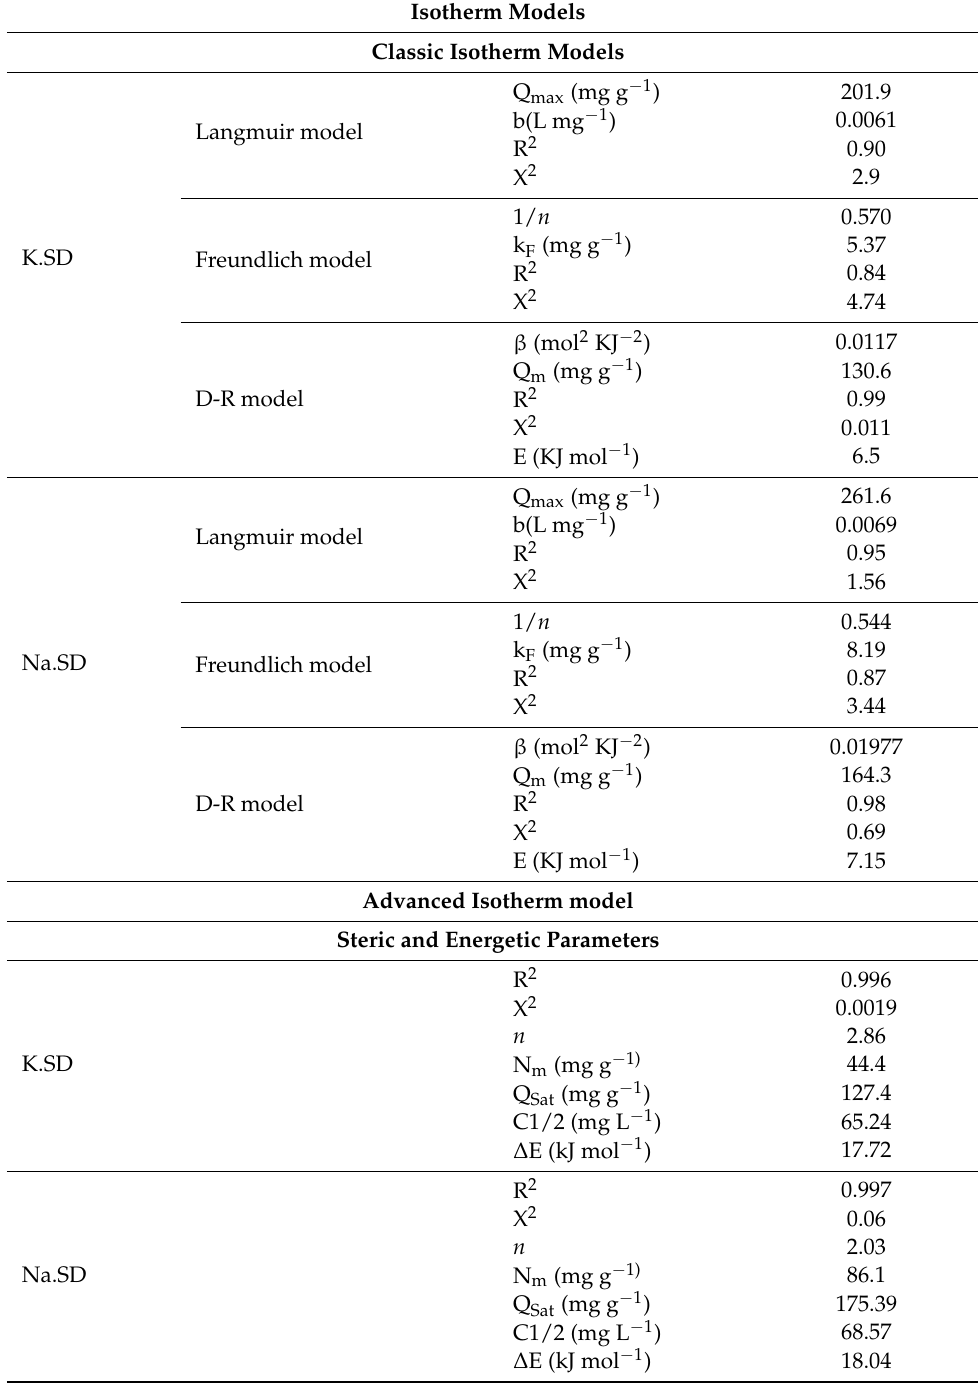
Table 4. Mathematical parameters of the evaluated classic and advanced isotherm